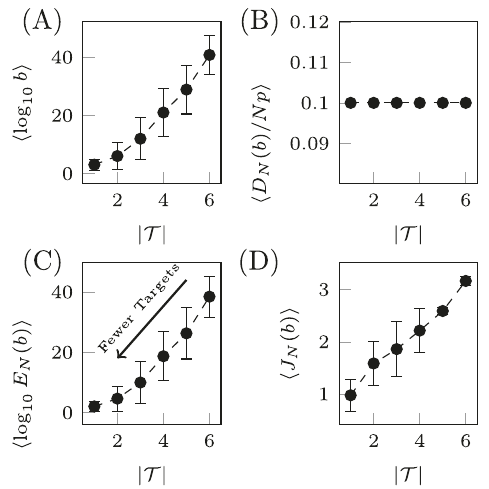
Fig. 6 Target control of network ensembles. The costs (weighting term b , deviation D N ( b ), control energy E N ( b ), and total cost J N ( b )) averaged over sets of target nodes of the same cardinality for the small network shown in Fig. 4A. The weighting term b is chosen such that D N ( b )/( Np ) = 0.1 and the result is shown in panel A . The deviation is shown in panel B where the desired value is seen to be achieved. In C , the control energy is shown where it is clear as the number of target nodes decrease, the control energy decreases exponentially. The total cost in D is seen to grow approximately linearly. Error bars represent standard